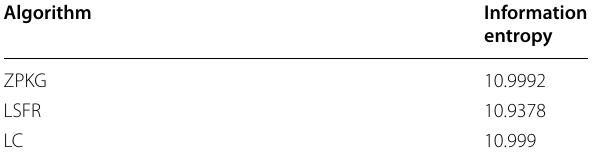
Table 2 Information entropy between different algorithms